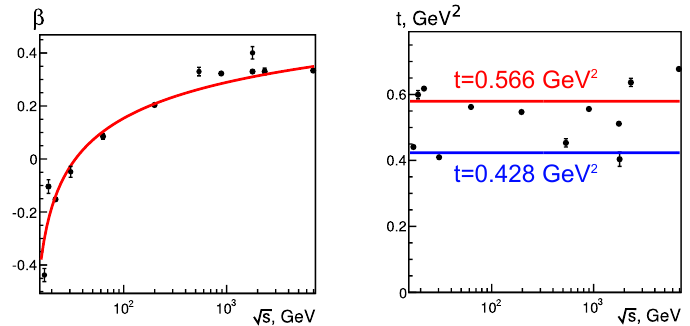
Figure 5. Dependence of model parameters β ( left ) and t ( right ) on energy [14].